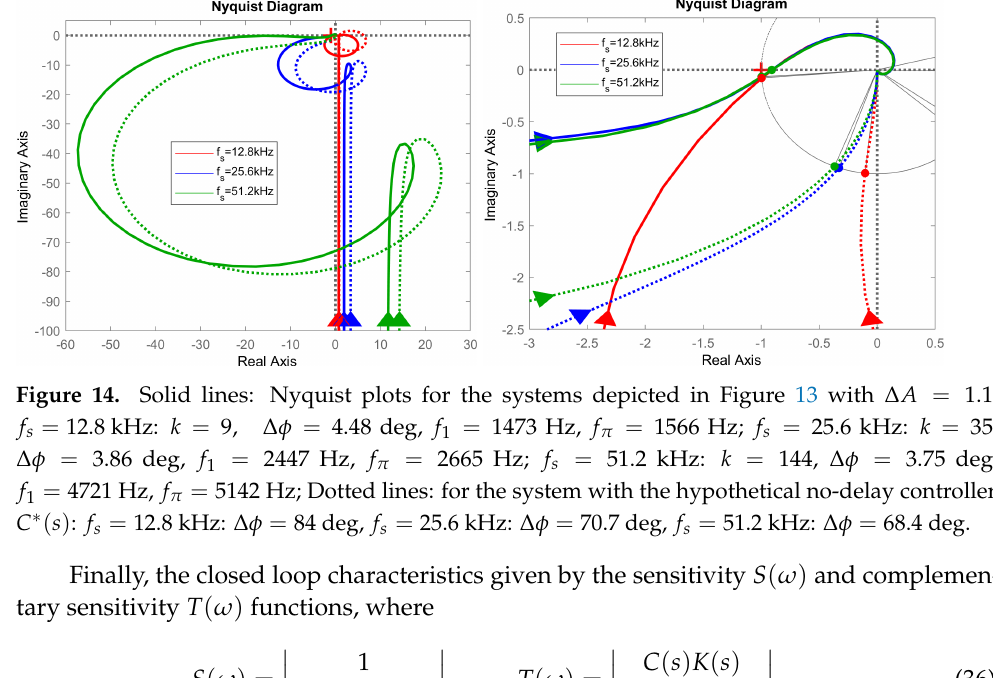
Figure 13. Bode plots ( a ) magnitudes for the LC filter with PID controllers, ( b ) phases of the LC filter with PID controllers. Solid lines are for C ( s ) , dotted lines—for C ∗ ( s ) , Vertical lines mark the frequencies, such that | C ( j ω ) K ( j ω ) | = 1. It is seen that there is only a small phase margin ∆ φ at these frequencies, and a quite large for the fictitious system C ∗ ( s ) K ( s ) without any delays caused by discrete-time data processing.